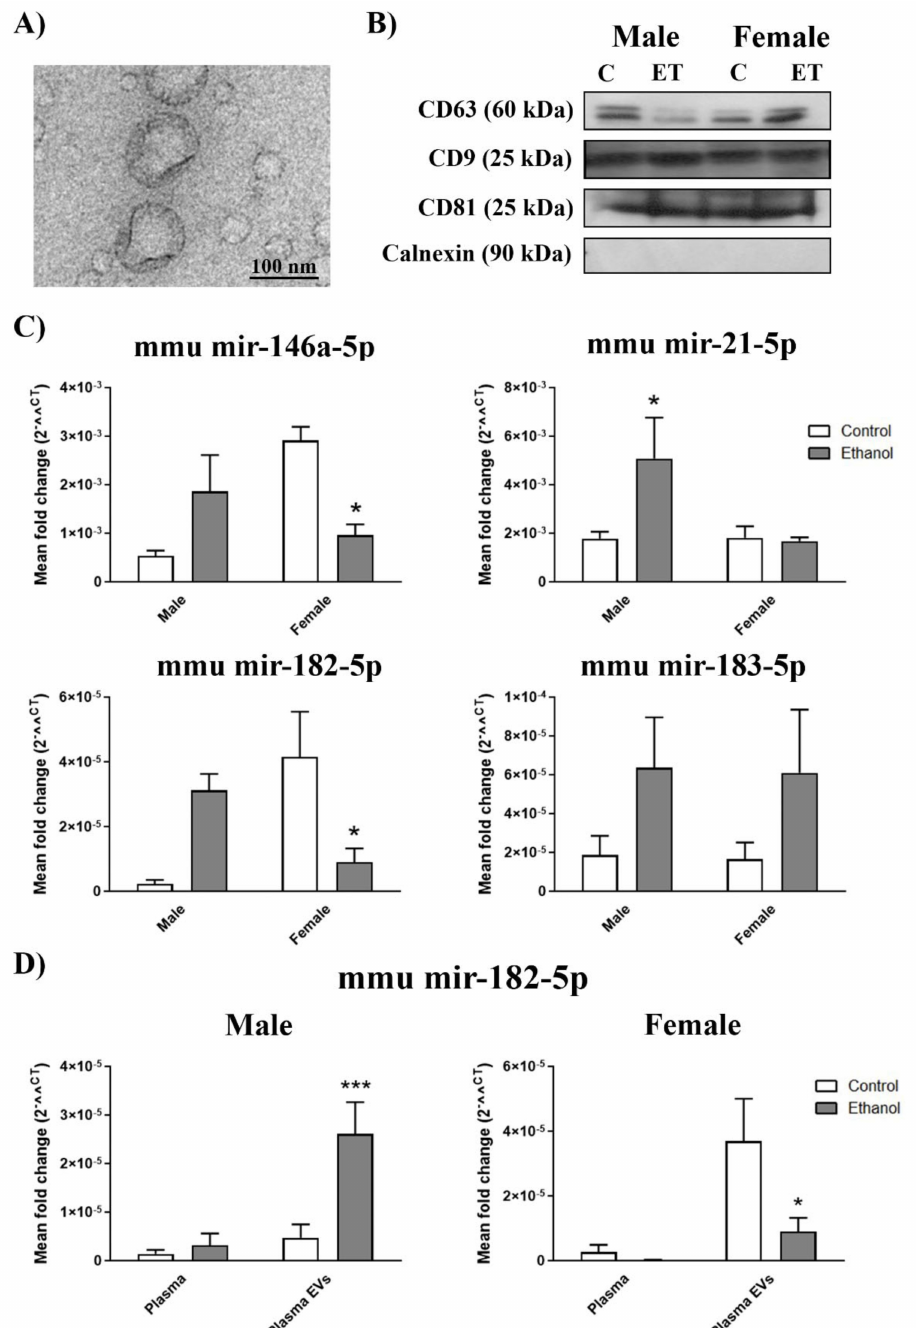
Figure 2. Inflammatory-related miRNA profile in the plasma EVs deriving from the ethanol-treated adolescent wild type (WT) mice. ( A ) Murine plasma EVs characterization by electron microscopy. Scale bar, 100 nm. ( B ) Representative immunoblots of the expressions of CD9, CD63, CD81, and calnexin of the murine plasma EVs. ( C ) Graphs represent the expressions of plasma EV miRNAs (mir-146a-5p, mir-21-5p, mir-182-5p, and mir-183-5p) after ethanol or saline treatment in the adolescent female and male WT mice (postnatal day (PND) 44). ( D ) Graphs represent the mir-182-5p expression in plasma and plasma EVs after the ethanol or saline treatment in the adolescent female and male WT mice (PND 44). Data represent mean ± SEM, n = 6 independent experiments. * p < 0.05, *** p < 0.001 compared to their respective control counterparts, according to the two-way ANOVA followed by the Bonferroni post hoc